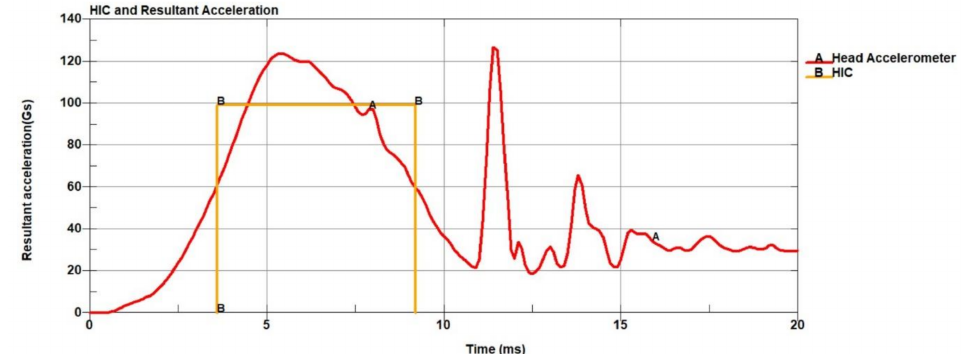
Figure A7. Course of simulation (0–20 ms, 5 ms interval) in configuration C.